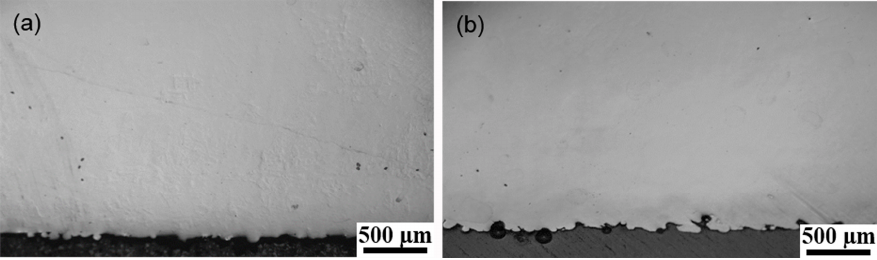
Figure 6. Optical microscope images showing the cross sections of ( a ) N6 and ( b )